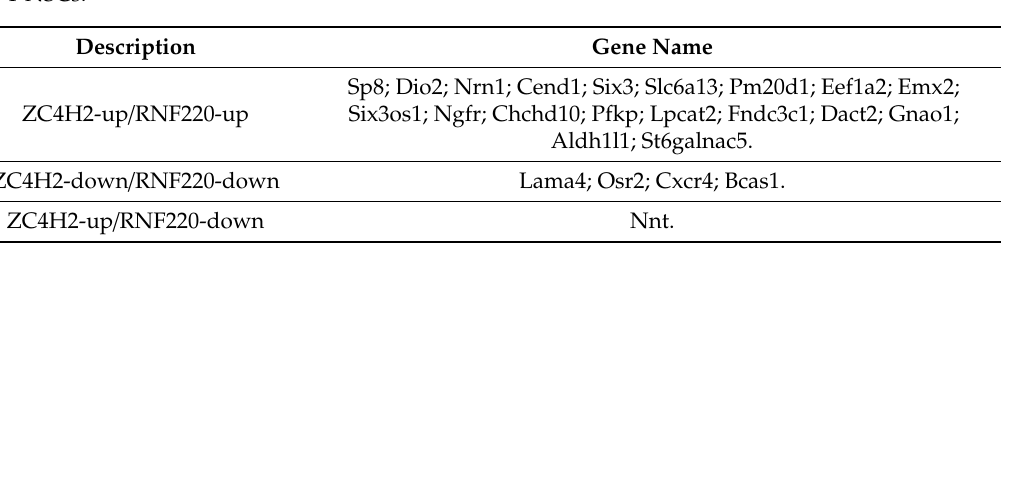
Figure 3. Gene Ontology (GO) classification and scatter plot-enriched Kyoto Encyclopedia of Genes and Genomes (KEGG) pathways of the di ff erentially expressed genes (DEGs) in the ZC4H2 − / − NSCs compared to the WT NSCs. ( A ) GO annotations showing significant enrichment of three main categories (biological process, cellular component, and molecular function) with the adjusted p -value < 0.05. The x -axis indicates the number of genes in each category. Top 10 terms of biological process and cellular component and all terms of molecular function were enriched. ( B ) KEGG enrichment result. The x -axis represents the gene ratio, which refers to the ratio of DEG numbers annotated in the pathway term to all gene numbers annotated in the pathway term. The circle size indicates the number of DEGs that are associated with each significant pathway. The circle color indicates the significant level with the adjusted p -value < 0.05. Table 2. The 24 DEGs shared between the two gene sets of ZC4H2 − / − versus WT and RNF220 − / − versus WT